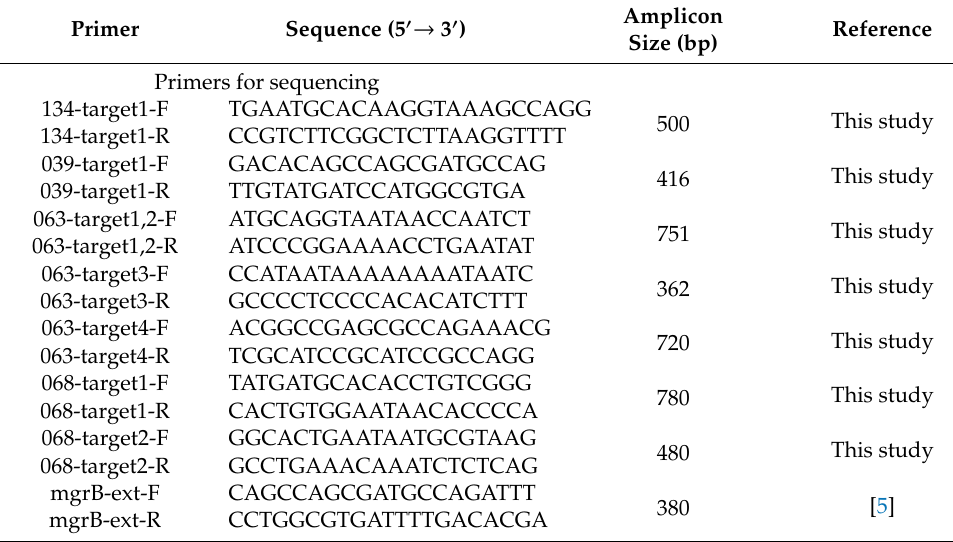
Table 4. Primers used in this